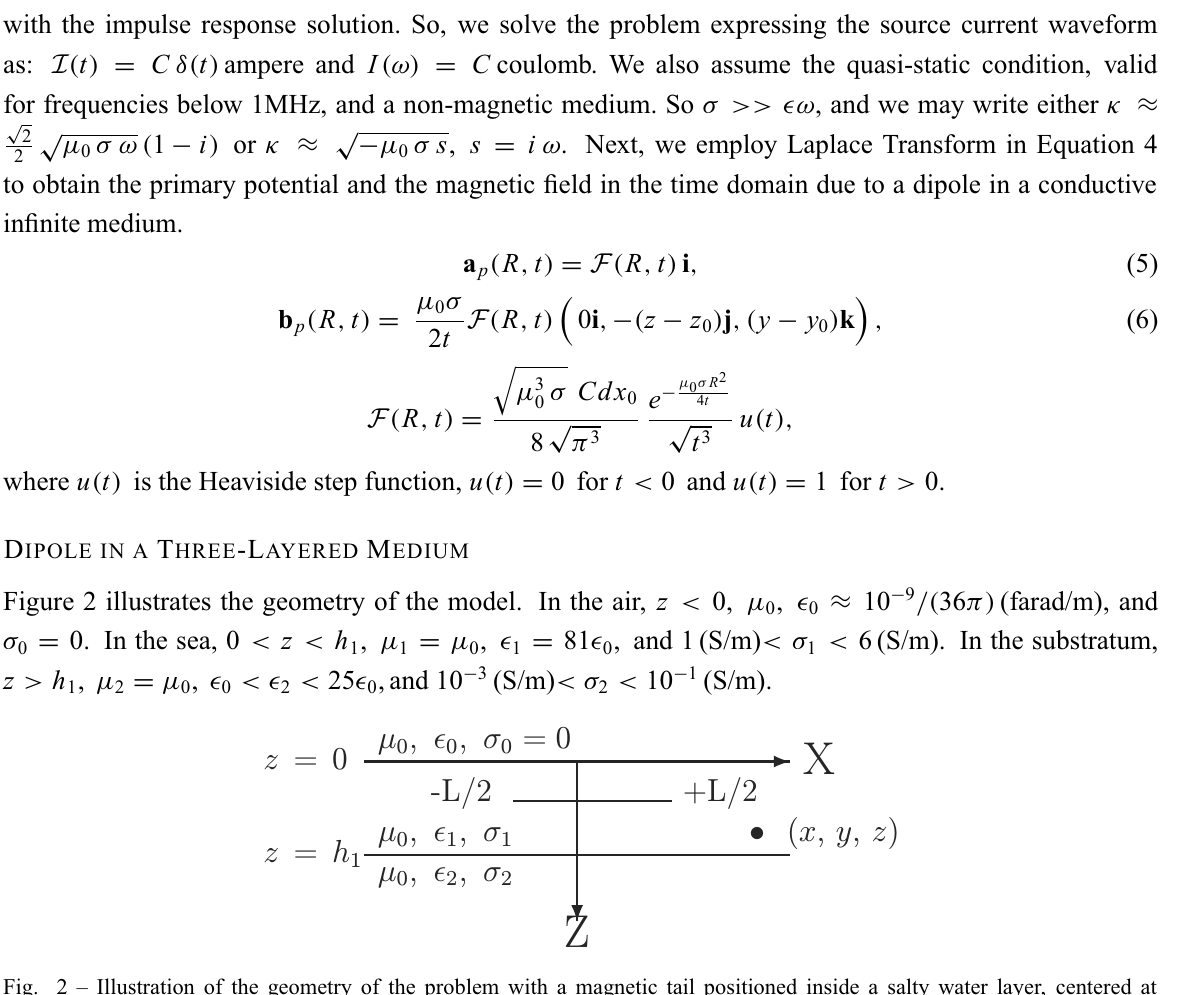
Fig. 2 – Illustration of the geometry of the problem with a magnetic tail positioned inside a salty water layer, centered at y 0 = 0, 0 ≤ z 0 ≤ h 1 and laid between − L / 2 ≤ x 0 ≤ + L / 2. Observation point at ( x , y , z ) of a homogeneous and isotropic three-layered